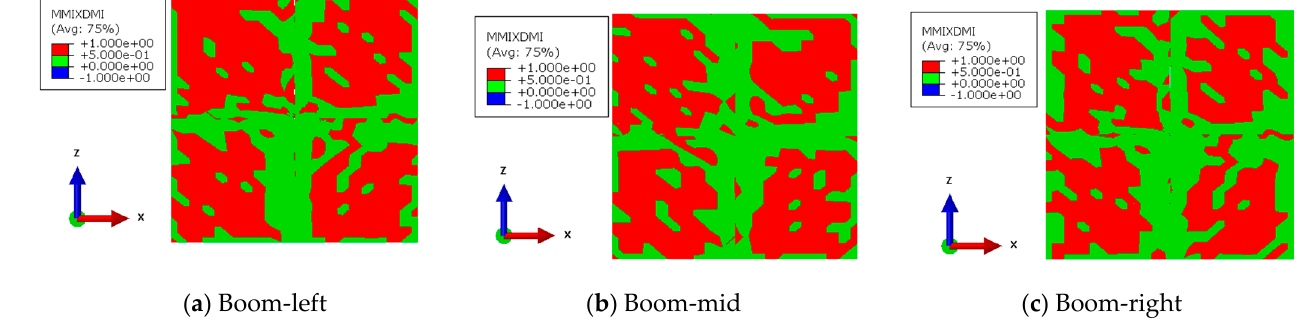
Figure 6. Horizontal fracture morphology at the deflagration point (green indicates failure, and the larger green area indicates the smaller fracture area).